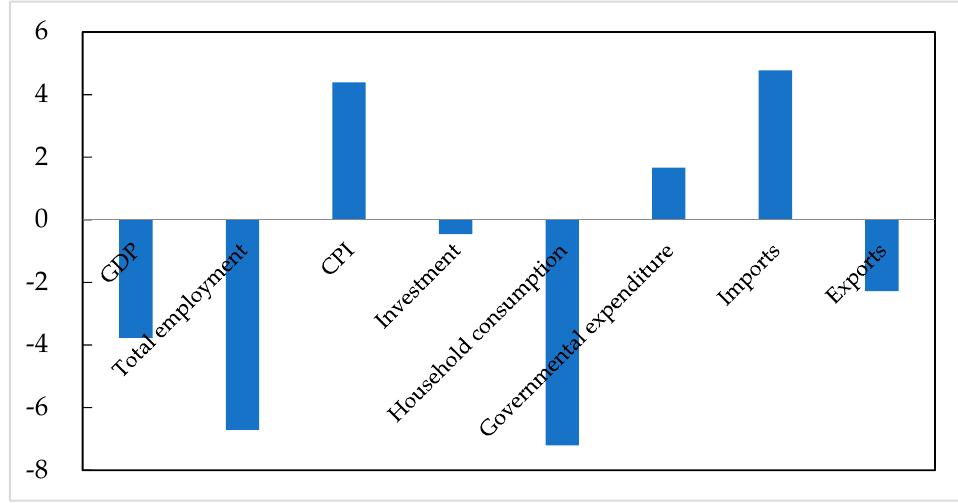
Figure 4. The impact of the COVID-19 pandemic on China’s macro-economic variables (%). Source: CHINAGEM model.